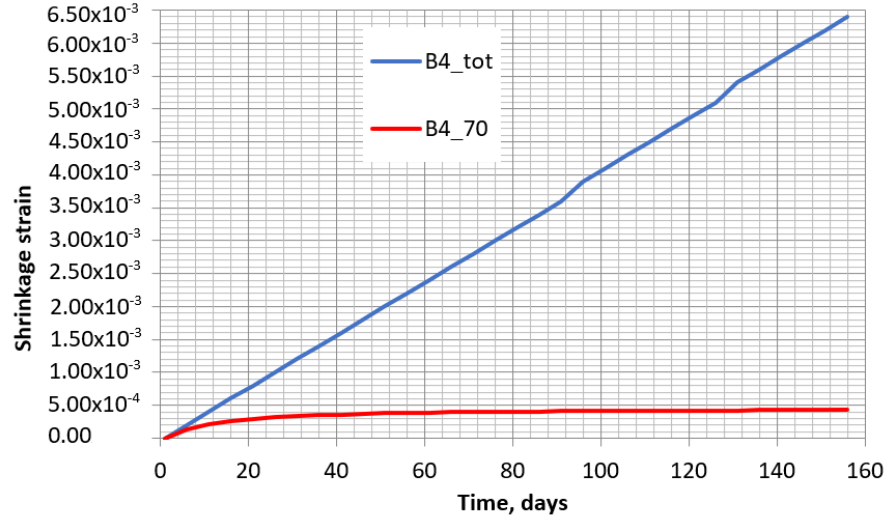
Figure 12. Shrinkage obtained according to B4 model (B4_70) and sum of shrinkage at each interval (B4_tot) with 70% humidity.